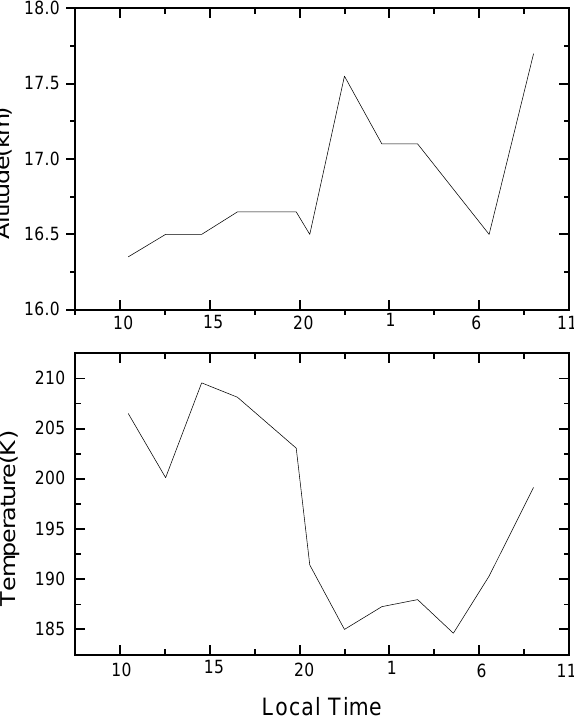
Fig. 5. Temporal variation of tropopause altitude and temperature during 11:00 LT on 24 August to 10:00 LT on 25 August